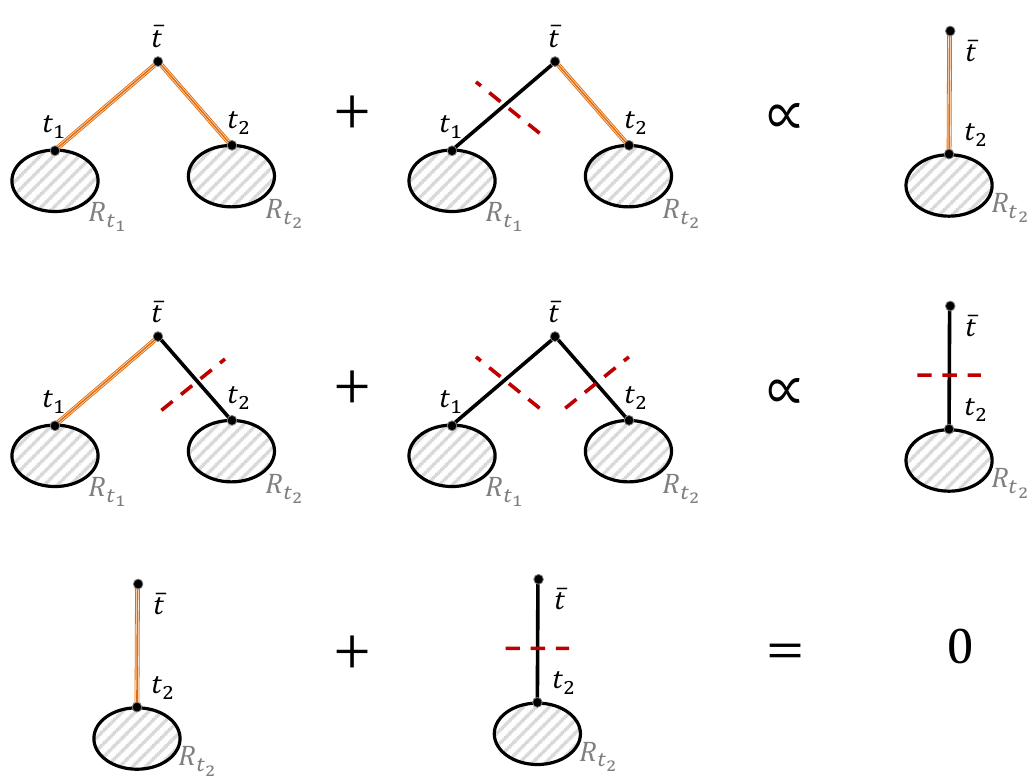
Figure 4 . There are four ways to cut two propagators attached to the largest time vertex, ¯ t . They can be paired together as shown in the first and second lines, which amputates all of the t dependence. The constants of proportionality are the same, and so adding the two diagrams as on the third line shows that this sum vanishes (see (4.11) and (4.12)).